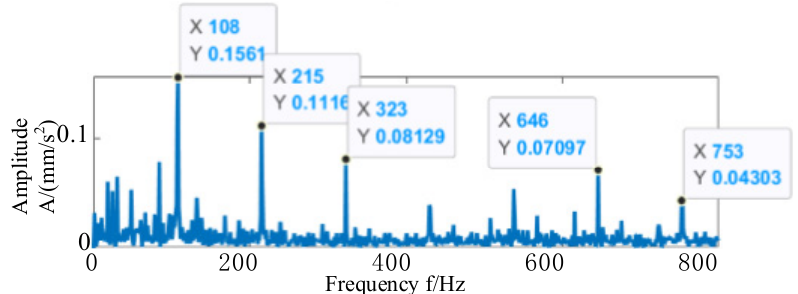
Figure 21. Envelope spectra of the transient shock characteristics.